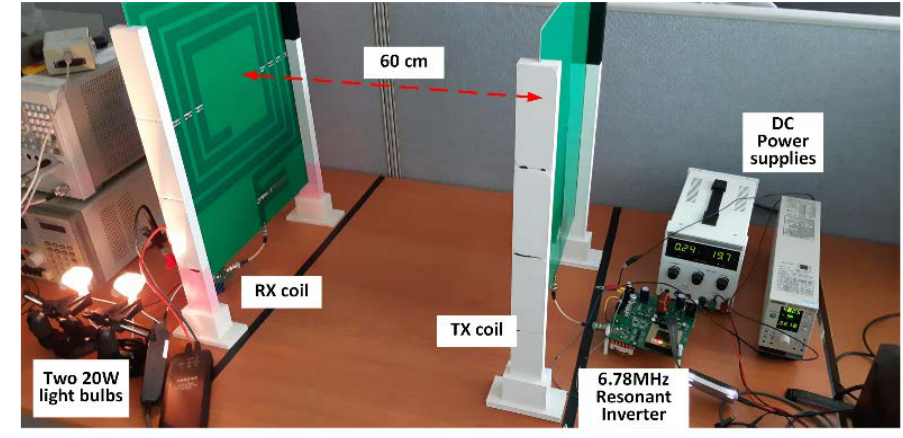
Figure 16. A photo of the experimental setup.